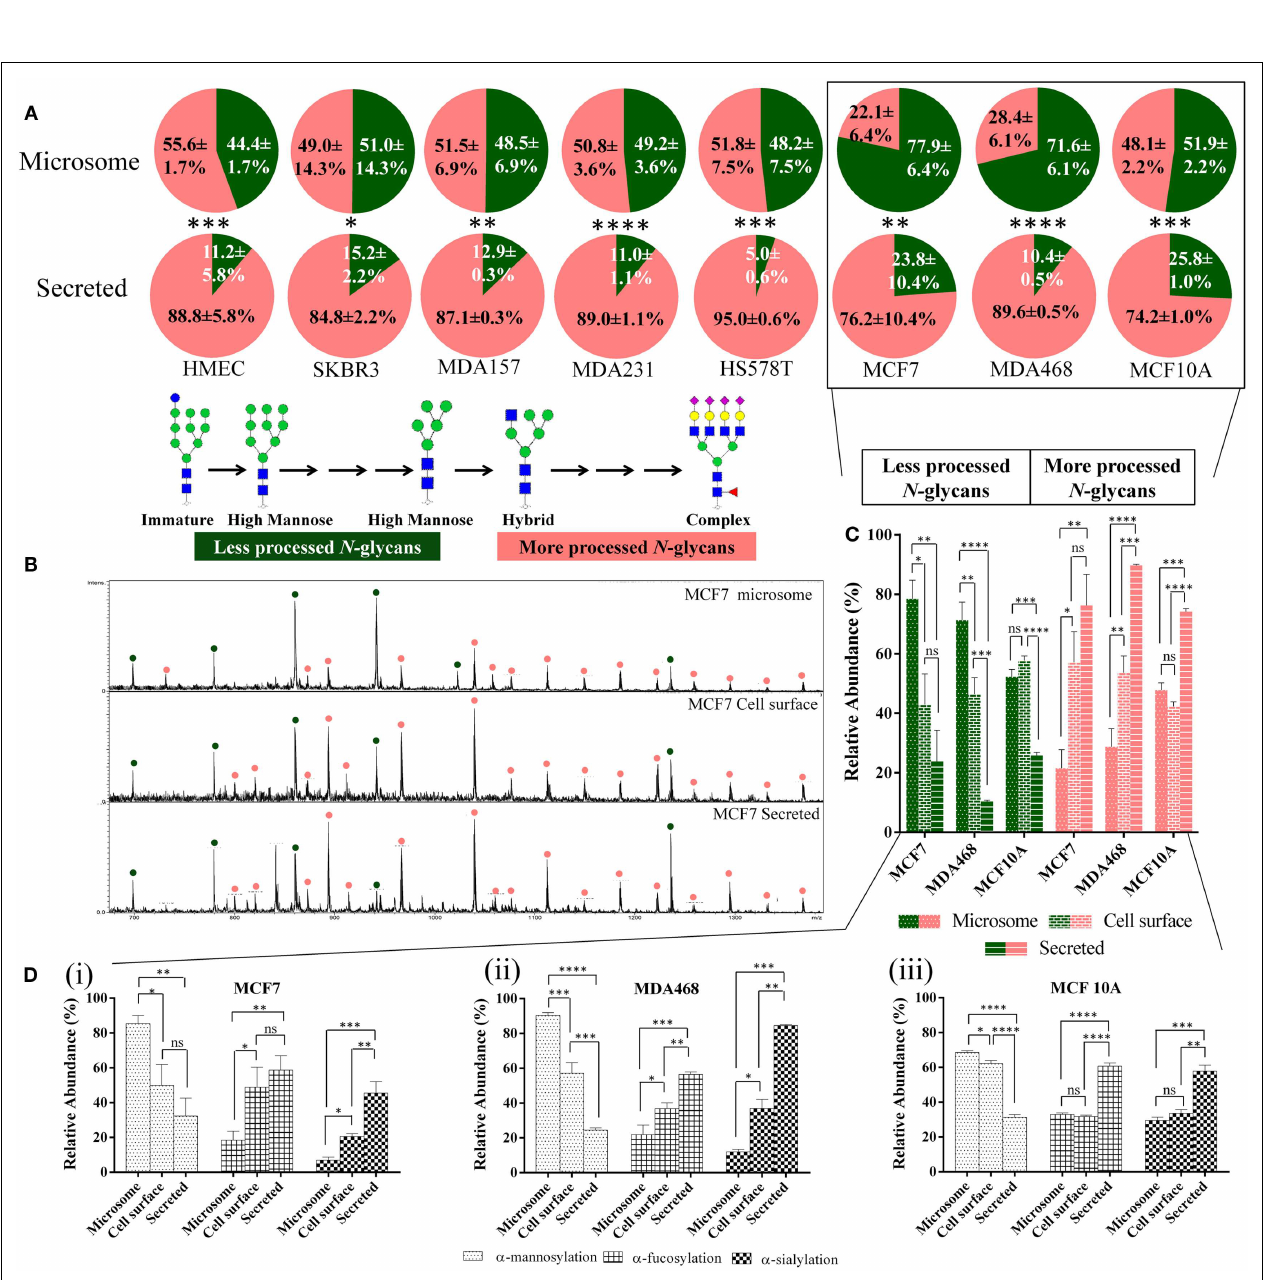
or more processed (light red) N -glycan types following the same classification as in (A) . (C) Relative molar distribution (mean ± SD) of more (right, hybrid/complex/paucimannose, light red bars) and less (left, high mannose, green bars) processed N -glycan types of the microsomal (dotted bars), cell-surface (brick), and secreted (banded) proteins of MCF7, MDA468, and MCF10A. (D) Subcellular-specific distribution of the N -glycan determinants.The proportion of terminal α -mannosylation, α -fucosylation, and α -sialylation (non-reducing end) N -glycans of the total N -glycome (mol/mol %) on the microsome, cell-surface, and secreted glycoproteomes across MCF7 (i), MDA468 (ii), and MCF10A (iii) breast cell lines were determined from the N -glycome profiles. N -glycans may terminate with multiple monosaccharide determinants making the values sum to more than 100%. For all panels: ns, not significant; * p < 0.05; ** p < 0.01; *** p < 0.001; **** p <